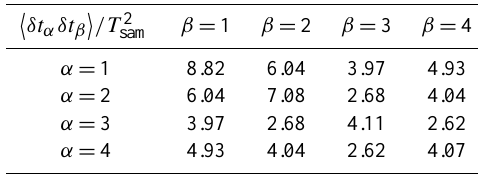
Table 1. Crossing time error analysis using a tanh pattern function: the solar wind discontinuity observed by the FGM instruments on- board the Cluster spacecraft shortly before and after 19:11:30UTC on 3 February 2003. The matrix elements are given in units of T 2 sam where T sam = 44 . 6ms is the sampling